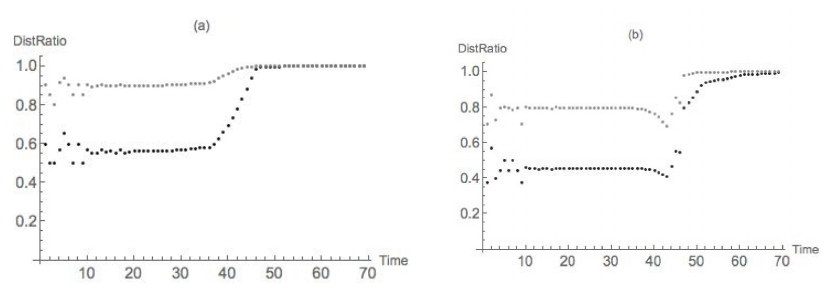
Figure 13. β 0 : Interpolation functions of average scalar curvature (denoted by R_avg, solid black line), bottleneck (gray), Wasserstein-1 (dark gray, dashed), and Wasserstein-2 (light gray, dashed) distances for ( a ) Nx = 25 and ( b ) Nx = 50 triangulations.